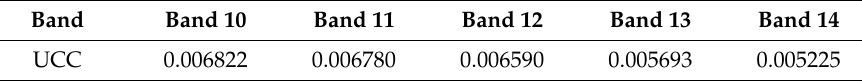
Table 4. Unit Conversion Coefficients (UCC) of ASTER’s TIR bands